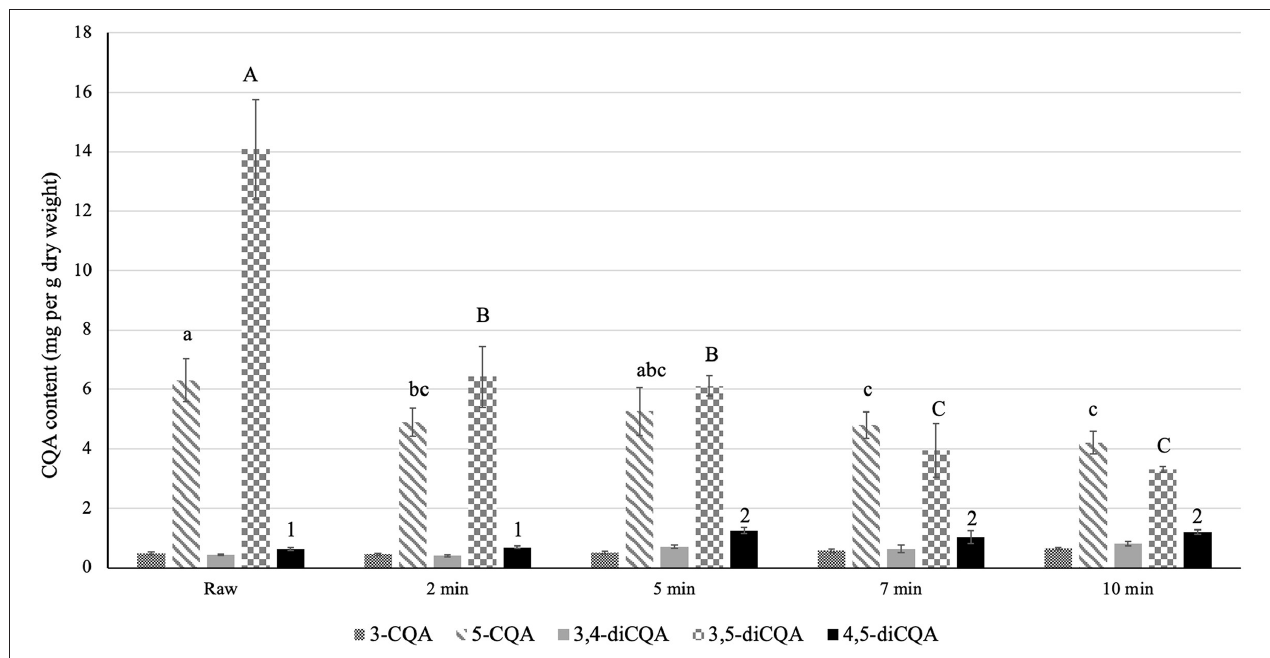
FIGURE 2 | Effect of cooking on the CQA content of sunflower sprouts. The CQA profile of sunflower sprouts were analyzed after cooking under controlled conditions (steaming for different time periods, including 2, 5, 7, and 10min). Error bars represent means ± standard deviations (SD), and three independent biological replicates were performed. For each CQA derivative, comparisons were made among uncooked (raw) and cooked samples at different timepoints; bars with different letters or numbers differed significantly according to Duncan’s multiple range test ( P < 0.05). The content of 3-CQA and 3,4-diCQA did not vary significantly among raw and cooked samples according to Duncan’s multiple range test ( P > 0.05).